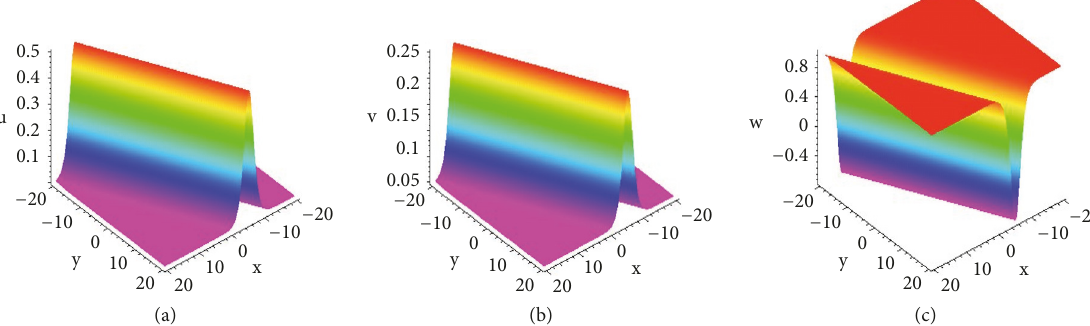
Figure 1: The plots of three line solitons expressed by (28) for the solution of (2) and (3) with the parameters 𝛼, 𝛽,𝛾, 𝜀, 𝑎,𝑐 1 ,𝑘 1 are all taken 1 , but 𝑙 1 = 1/2 .